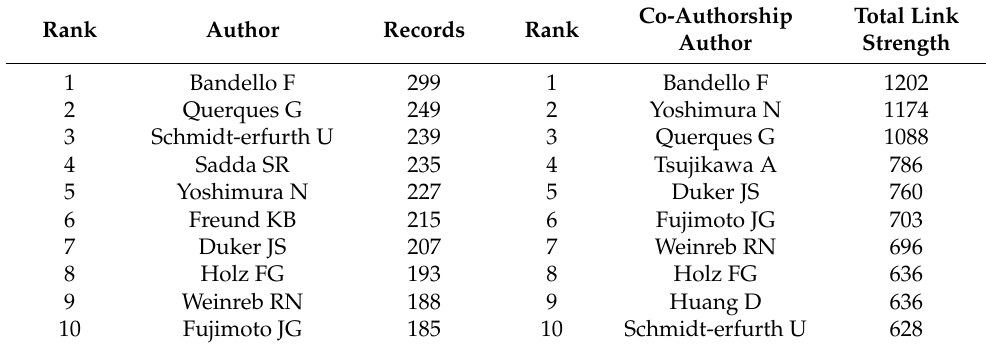
Table 4. The top 10 most productive and collaborative authors.